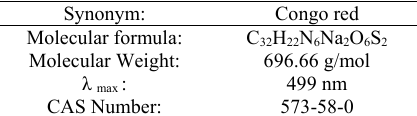
Table 1 The structure and characteristics of Congo red (CR) dye Table 1. The characteristics of Congo red (CR)